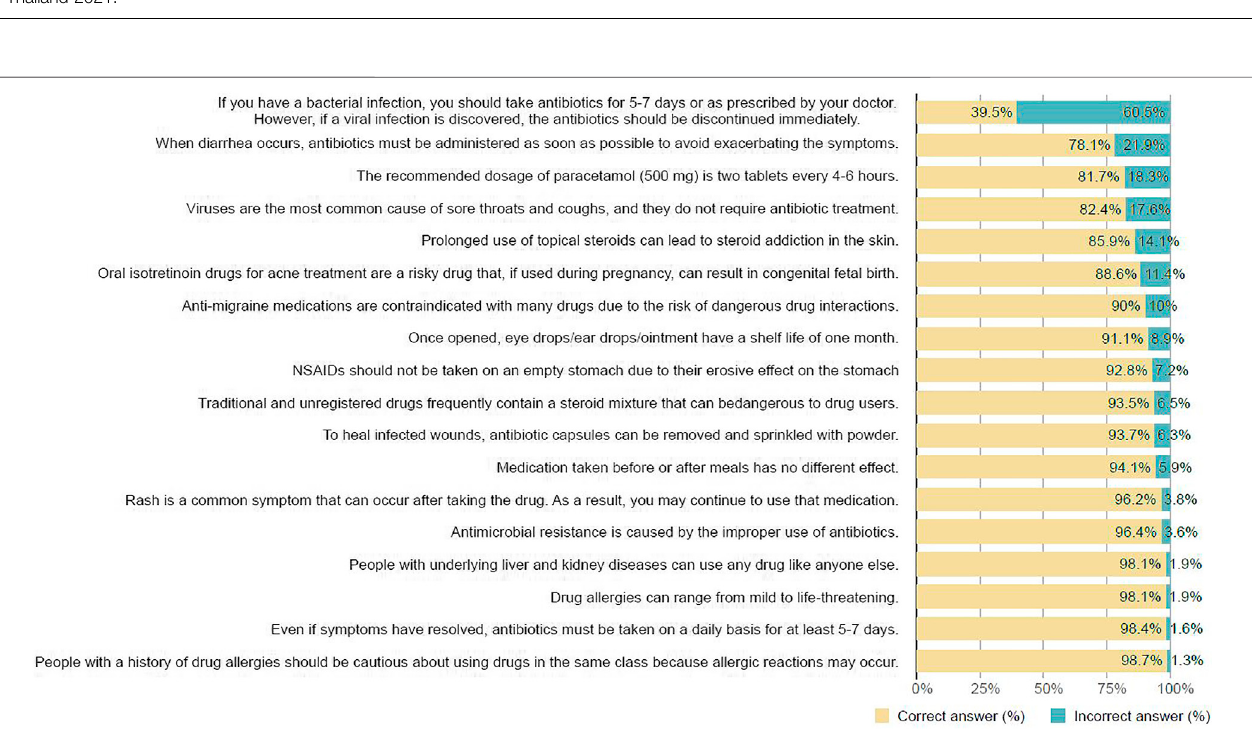
FIGURE 2 | Basic medication knowledge, Self-medication with over-the-counter medicines among the working age population in metropolitan areas of Thailand, Thailand 2021.